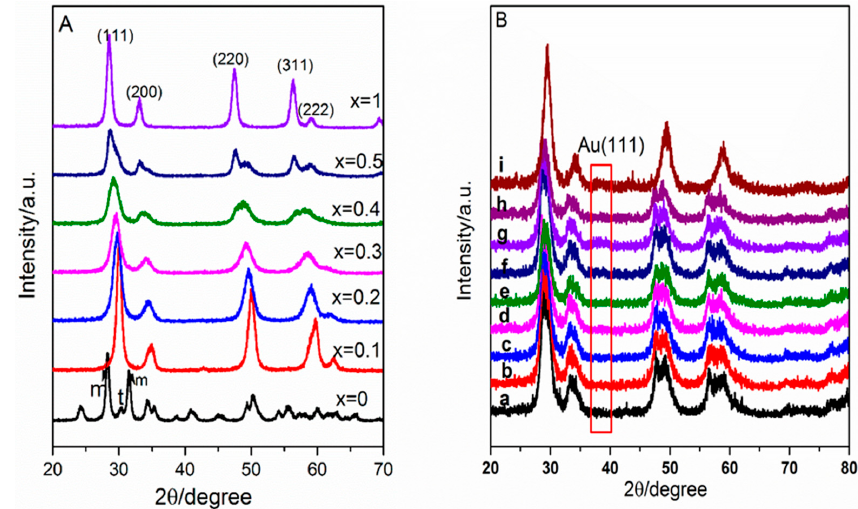
Figure 1. X-ray diffraction patterns of ( A ): Ce x Zr 1 − x O 2 support; ( B ): catalysts with different Au loadings and the used catalyst ( a 0.2 wt %, b 0.3 wt %, c 0.6 wt %, d 0.8 wt %, e 1 wt %, f 1.4 wt %, g 2 wt %, h 2.2 wt %, i the used catalyst after five runs).